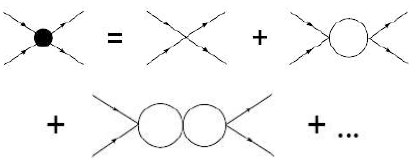
Fig. 1. Infinite bubble chain for nucleon-nucleon scattering under contact interactions that encode strong interactions.